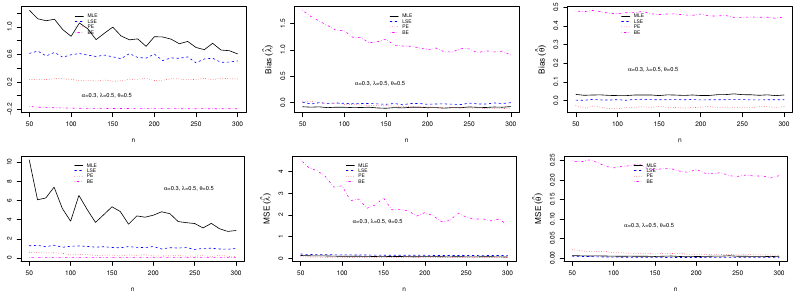
Figure 5. Plots of the bias and MSE for the different estimates of α = 0.3, λ = 0.5 and θ =